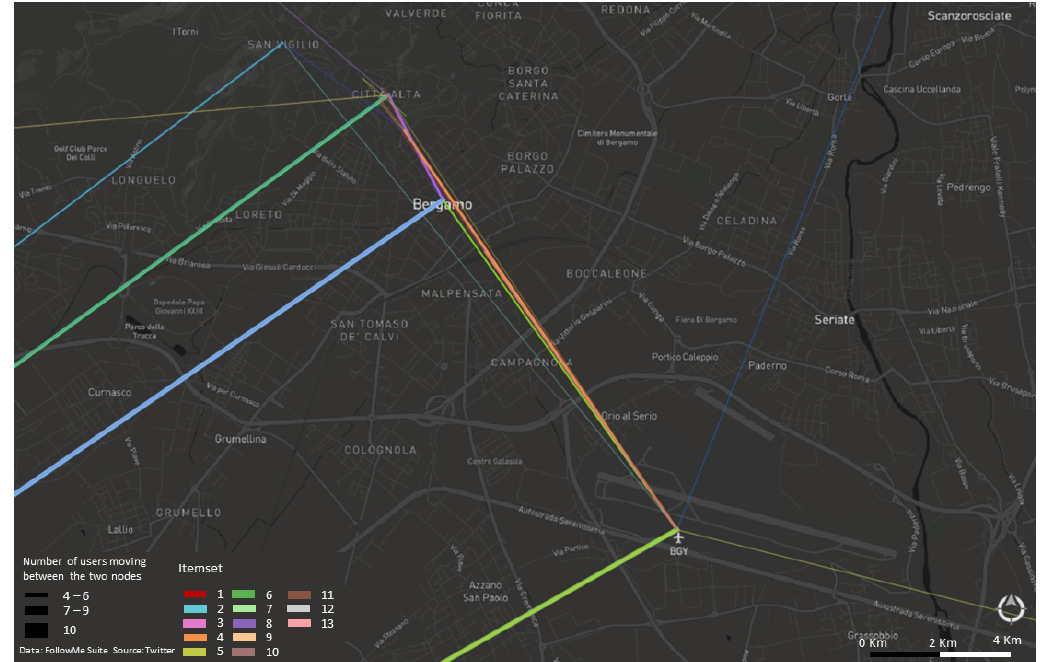
Figure 3. Topographic representation for discovered itemsets associating places (Interpretation 1), focused at the level of Bergamo